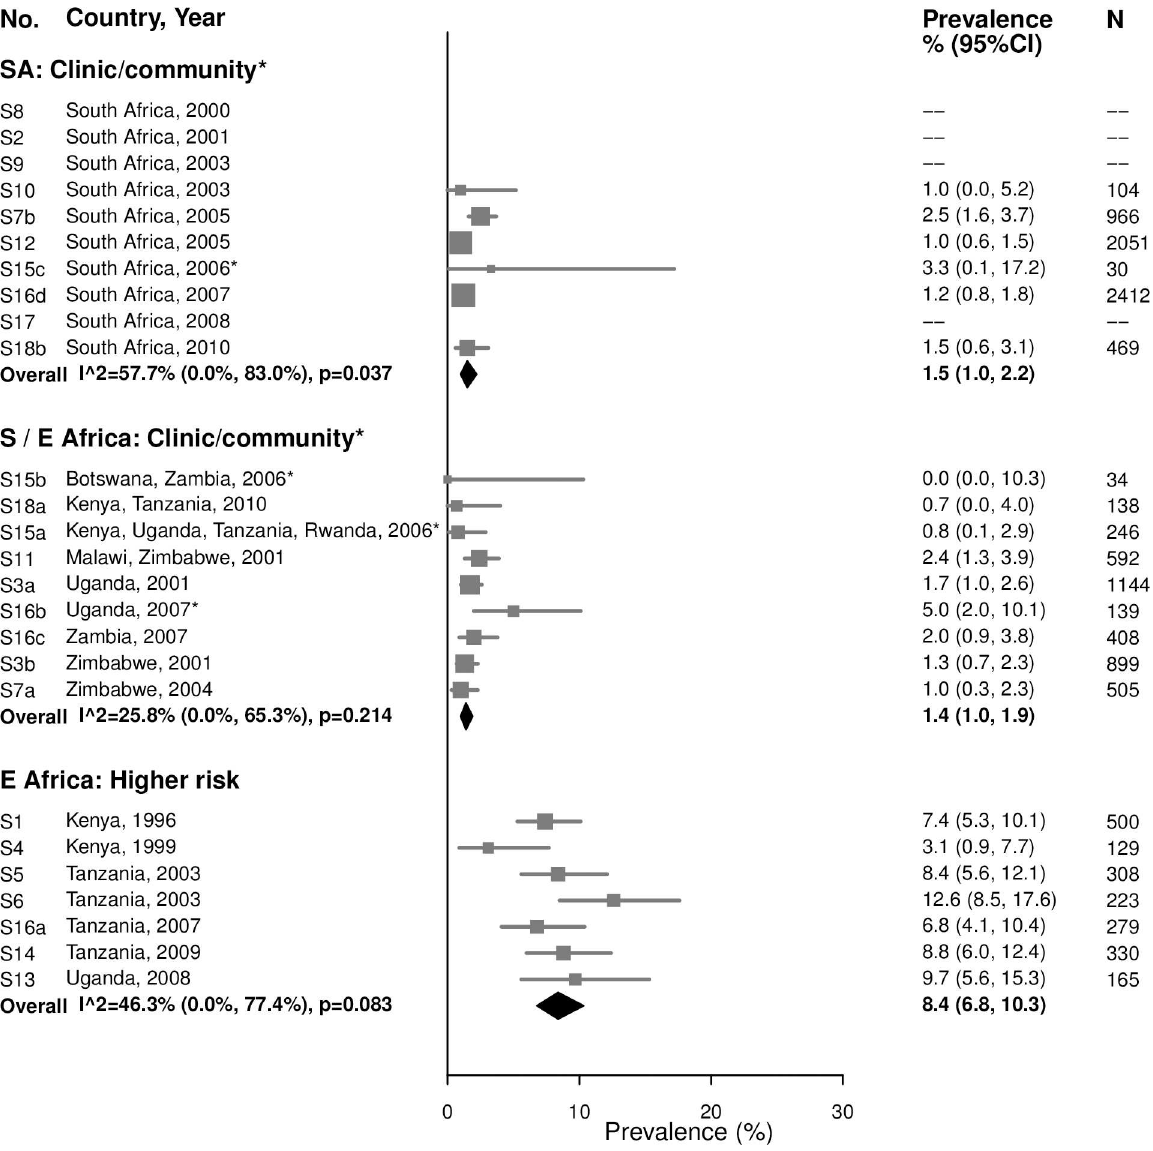
Fig 5. Syphilis overall prevalence among 15–24-year-olds. The area of the marker is proportional to the square root of the sample size. Studies with no estimate presented did not meet the inclusion criteria for this infection and age group. Year presented is the median year that baseline data were collected during the study. (cid:3) Includes studies of HIV-discordant couples. E Africa, Eastern Africa; SA, South Africa; S/E Africa, Southern and Eastern